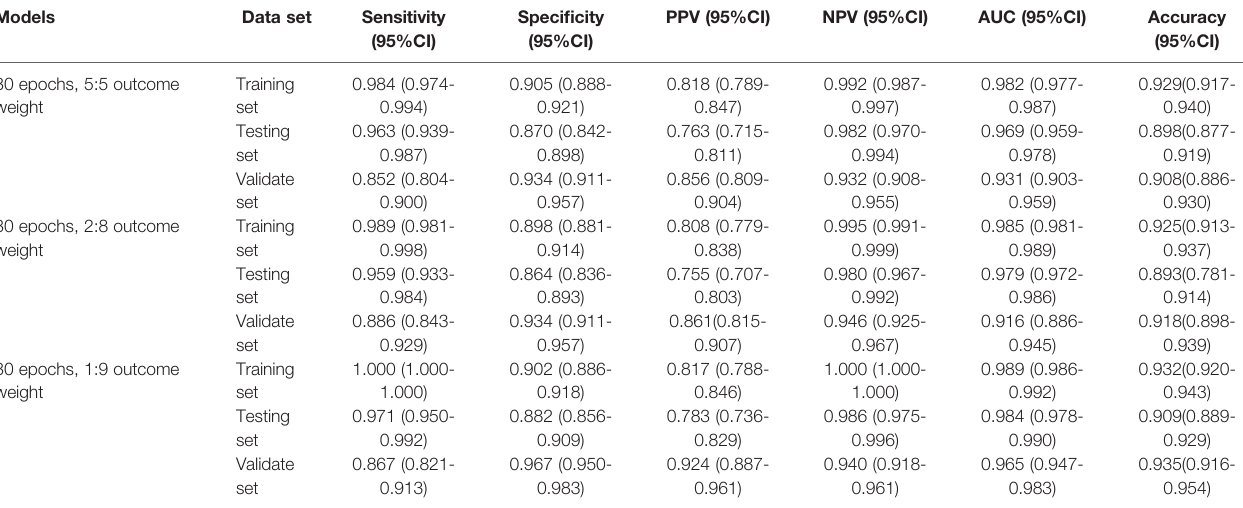
TABLE 1 | The performances of the MDS two-classi fi cation model with different outcome weights.